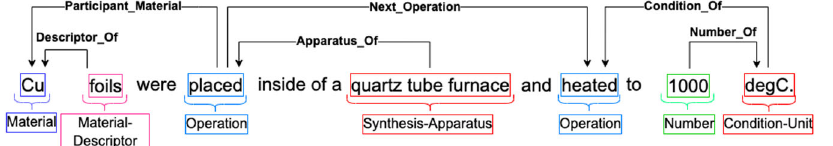
Fig. 6 Relation classi fi cation task. The different entities are enclosed in boxes with their respective labels. The related entities are connected using arrows labeled with the